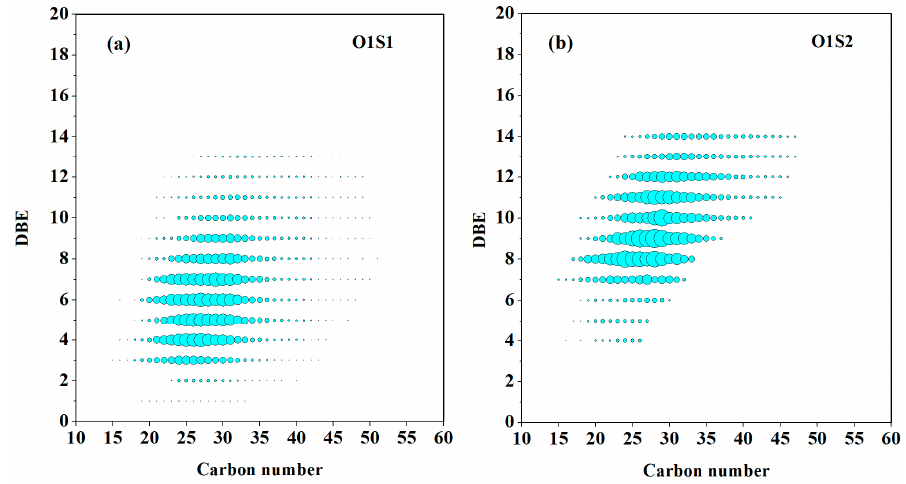
Figure 4. Isoabundance pattern for DBE versus the carbon number of the sulfides species for the LGAR aromatics: ( a ) O1S1; ( b ) O1S2. Note: The size of dot corresponds to the abundant of sulfides species in the sample. The largest dot correspond to the most abundant O1S1 and O1S2